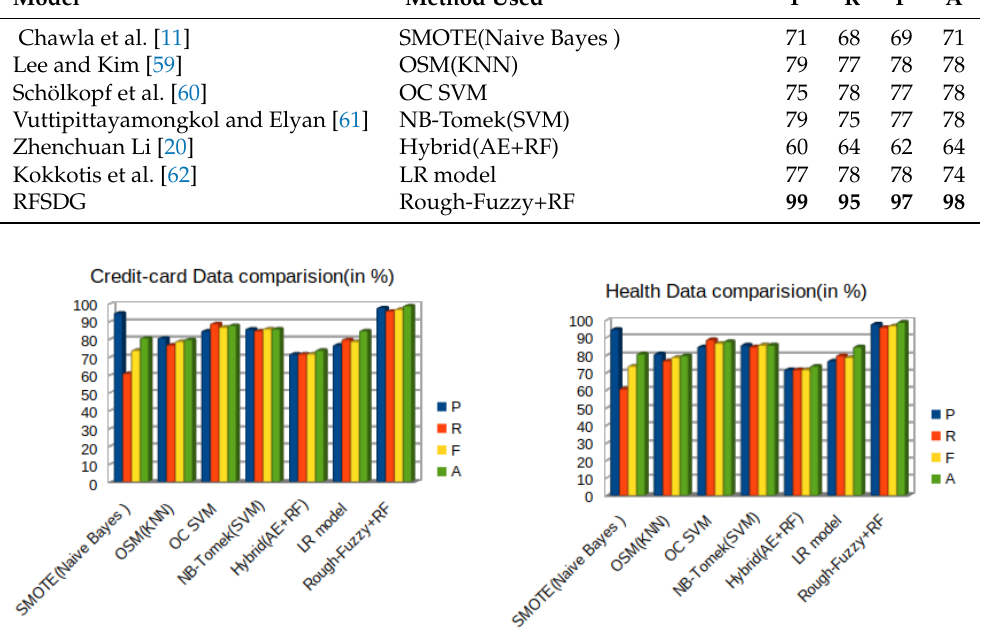
Table 4. Comparison (in %) of different methods on Health data. Model